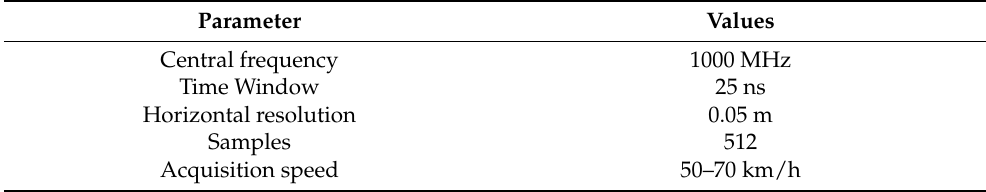
Table 1. GPR acquisition